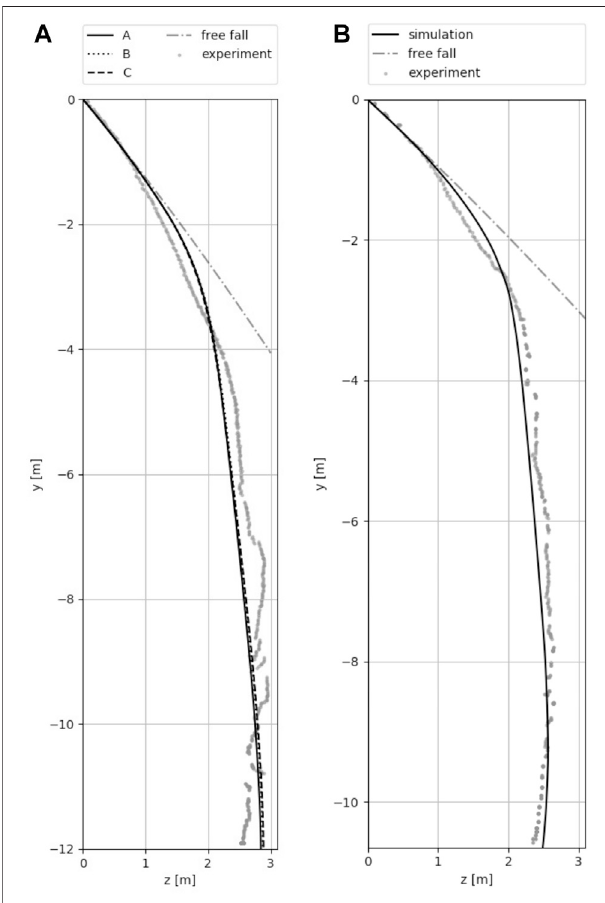
FIGURE 12 | Visualization of object path. Additionally, the free fall trajectory is added to demonstrate the correctness of the object path at the beginning of the simulation and the effectiveness of the Attenuator barrier. (A) The three optimal parameter combinations for T092. The solution for parameter set B is very similar to the one for parameter set A and thus not easily distinguishable. (B) T089 with parameter set